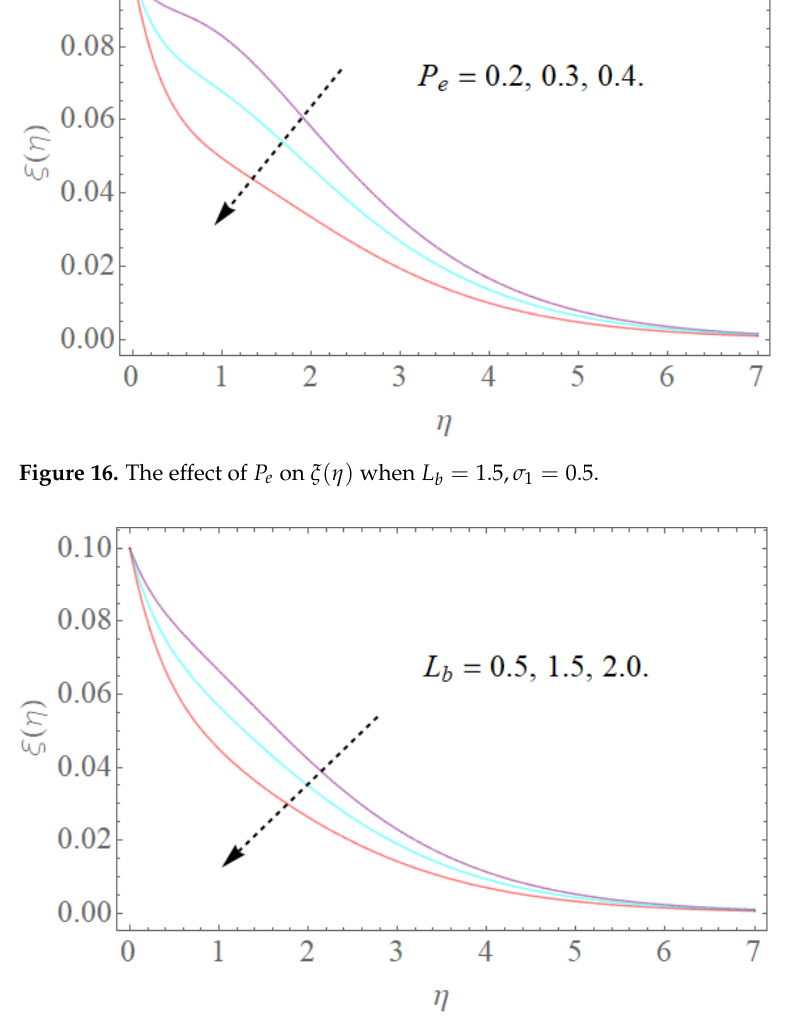
Figure 17. The effect of L b on ξ ( η ) when P e = 0.4, σ 1 = 0.5.